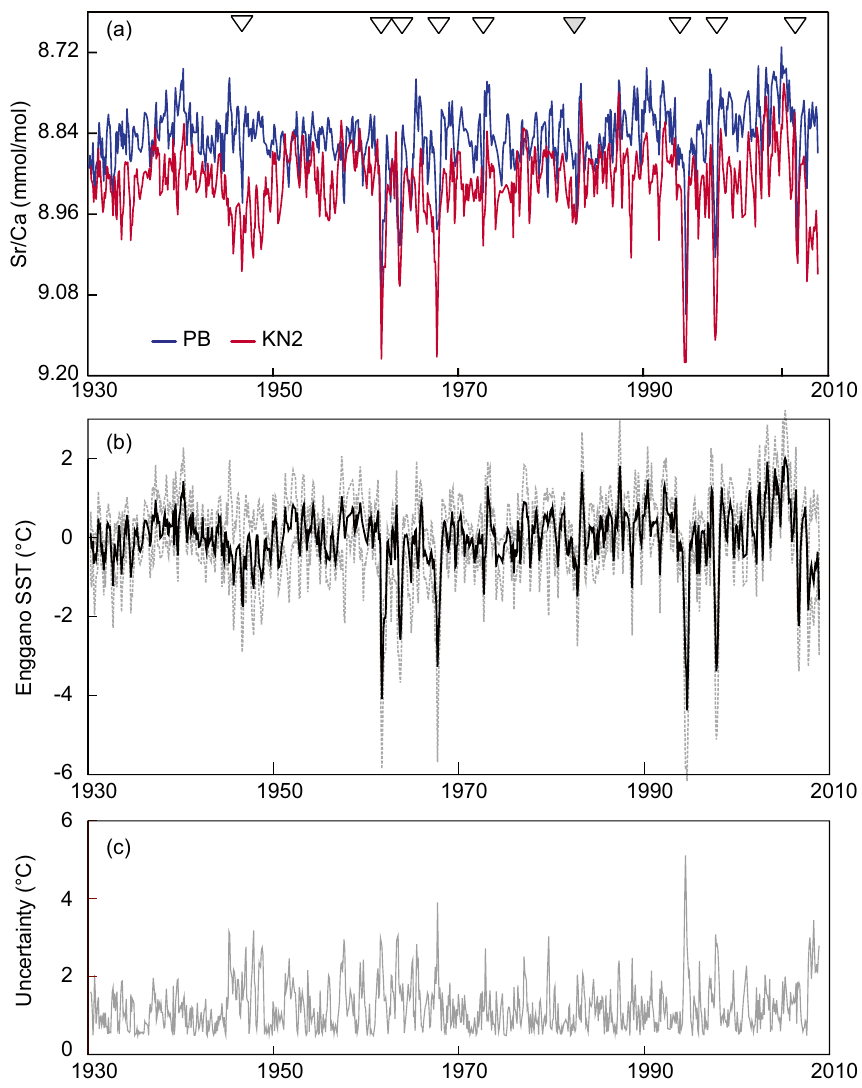
Figure 2. ( a ) Monthly coral Sr/Ca records of KN2 and PB. ( b ) Enggano coral SST record estimated from KN2 and PB (black solid line). Uncertainty envelopes (95% confidence levels, gray dashed line) are estimated via a Monte Carlo approach 23,24 . ( c ) Uncertainty of the Enggano SST record in °C. Arrows in ( a ) mark extreme pIOD events of 2006, 1997 and 1994 discussed in 11 , the El Niño year of 1982 (grey arrow), and the true pIOD events of 1972, 1967, 1963, 1961 and 1946 listed in 28 (from right to